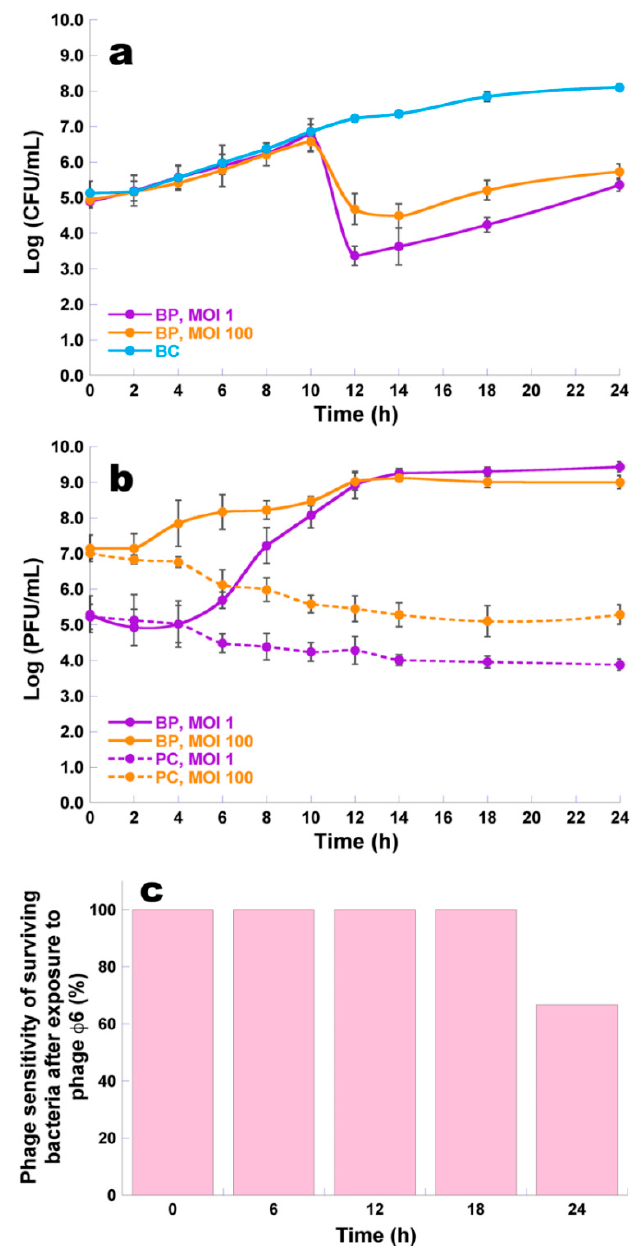
Figure 6. Inactivation of P. syringae pv. syringae by phage φ 6 at a multiplicity of infection (MOI) of 1 and 100 during 24 h. ( a ) Bacterial concentration: BC, bacteria control; BP, bacteria plus phage; ( b ) Phage concentration: PC, phage control; BP, bacteria plus phage; ( c ) Percentage of phage sensitivity of surviving bacteria after phage exposure of P. syringae pv. syringae cells sensitive to phage φ 6 at a MOI of 1, after 0, 6, 12, 18, and 24 h of incubation, following spot testing of randomly chosen bacterial colonies. Values represent the mean of three independent assays; Error bars represent the standard deviation.